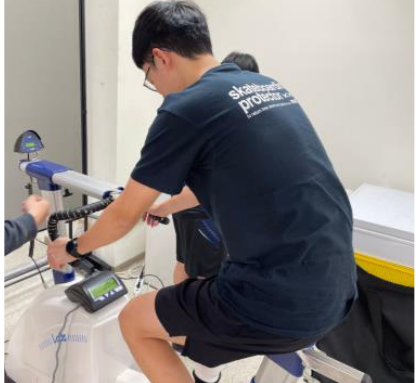
Figure 19. A subject riding an indoor bicycle.